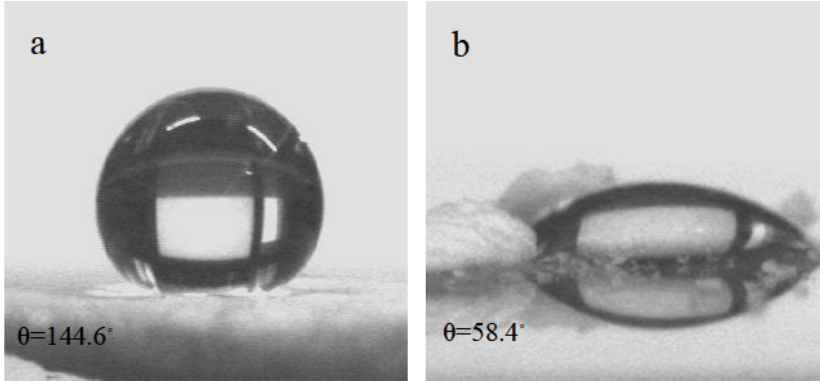
Figure 4: Contact angle of SiO 2 (AG) of SiO 2 (AG) (a: hydrophobic; b:hydrophilic)